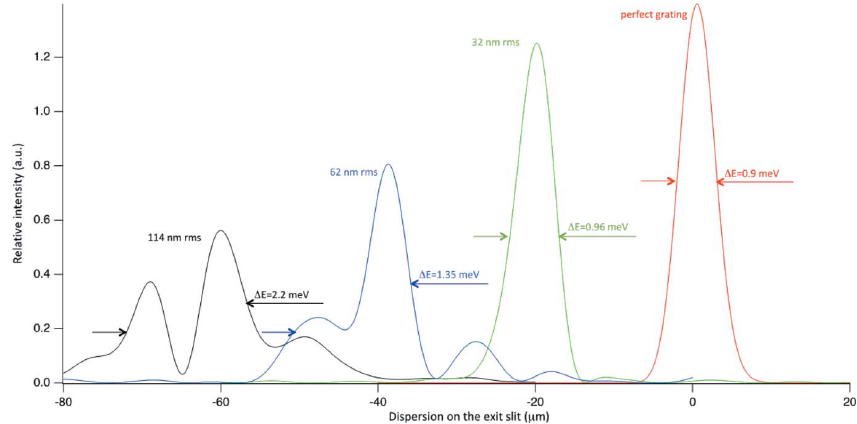
Figure 9 Results of wavefront propagation for the HEG at 100 eV for various r.m.s. groove-placing errors. Each curve is reported with its FWHM in meVand with the associated r.m.s. groove placing error. Line colors match text